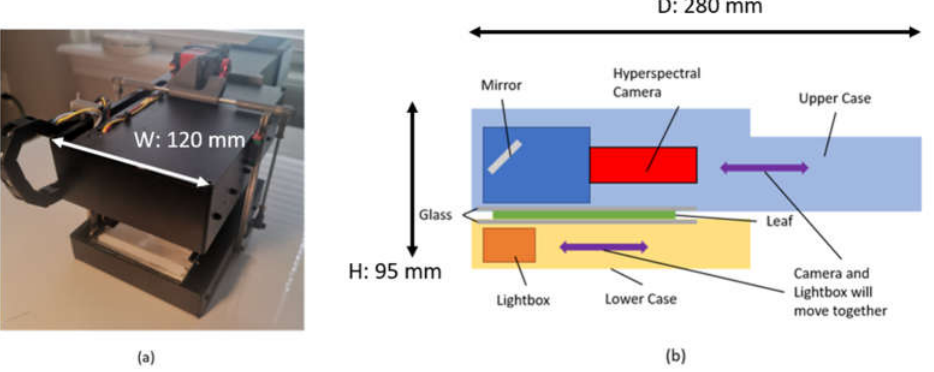
Figure 2. LeafSpec Handheld HSC for dicot leaf: ( a ) LeafSpec for dicot leaf picture; ( b ) Internal structure of the LeafSpec for dicot leaf device.